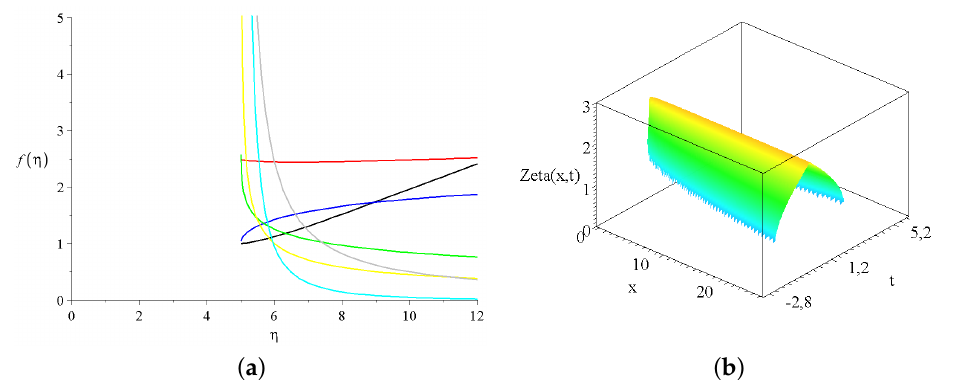
Figure 4. The shape function and the solution for the spatial and temporal dependence of the wave height. ( a ) The shape function of the wave height f ( η ) for seven different α exponents for the linear seabed function. The black, blue, red, green, yellow, gray and light blue lines correspond to − 1, − 1/2,0,1/2,3/2 and 2 values, respectively. The integral constants c ( b ) the wave height projection ζ ( x , y = 0, t ) = t − α f ( η ) for γ = 2 other integration constants, and the water depth remains the